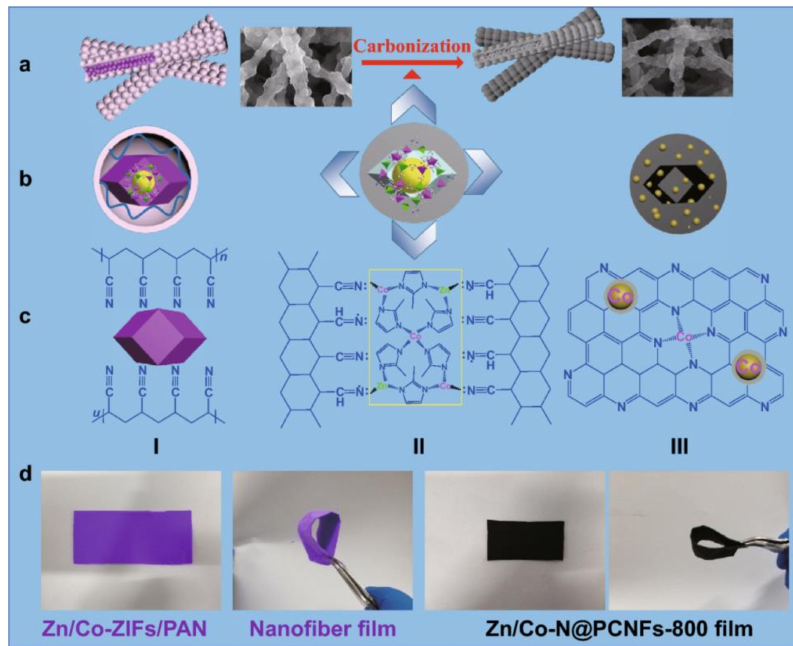
Figure 2. Schematic illustration of ( a ) sketch of the structures and SEM photos of the nanofibers, ( b ) simulated cross-sections, ( c ) simulated molecular structures, ( d ) digital photographs of the Zn / Co-based nanofibers film before and after direct carbonization at 800 ◦ C. Reproduced from reference [95] under CC BY 4.0